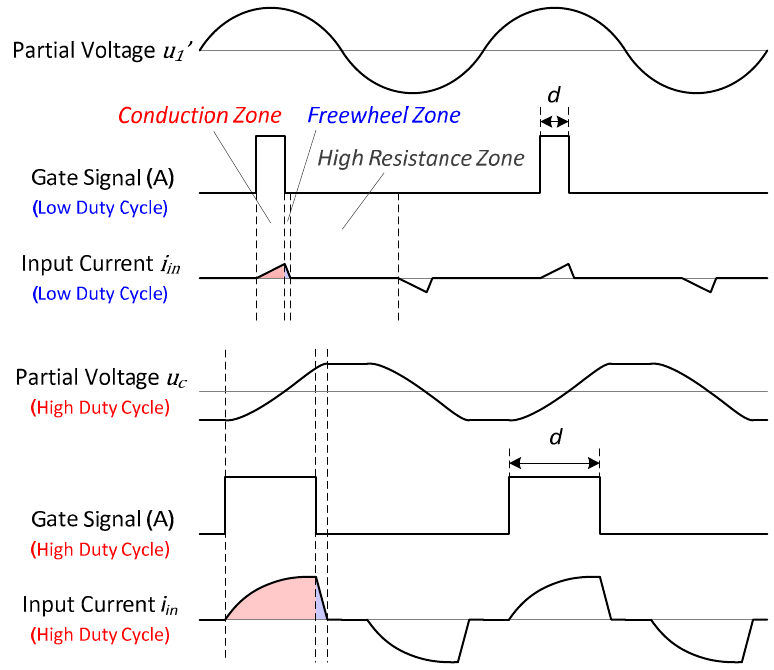
Figure 6. Typical waveforms of the proposed scheme.